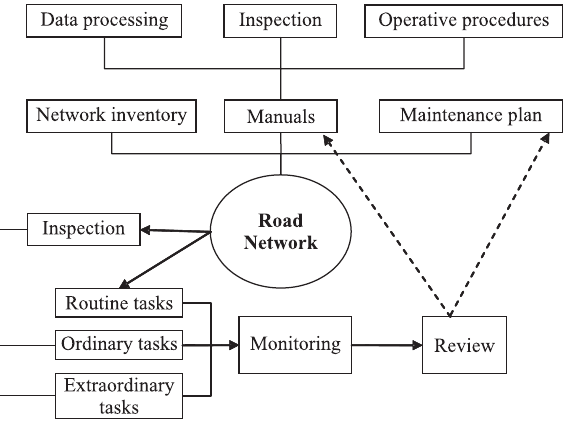
Fig. 1. General organisation of the road maintenance